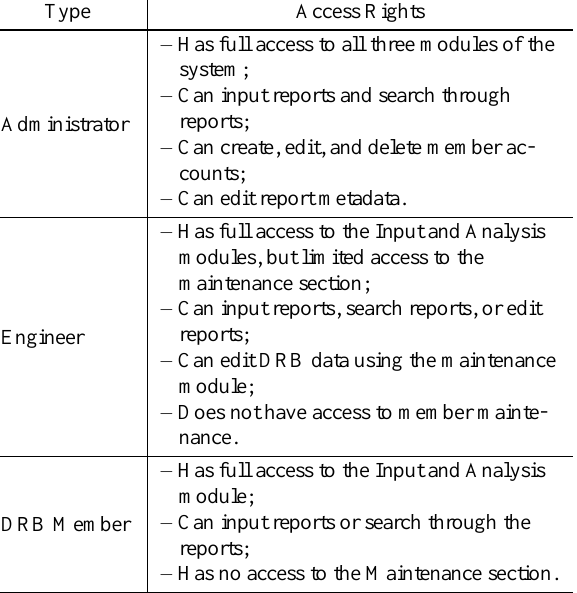
Table 1. Access Rights of Different